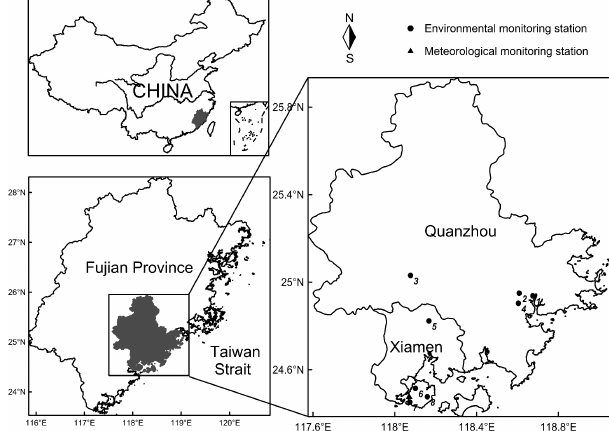
Figure 1. Locations of Fujian province in China (shaded areas, up- per left panel) and the Xiamen and Quanzhou region (XQR) in Fu- jian province (shaded areas, lower left panel), and the distribution of nine monitoring stations (eight environmental sites with black dots numbering from 1 to 8, and one meteorological observatory of Xiamen with a black triangle) over XQR (lower right